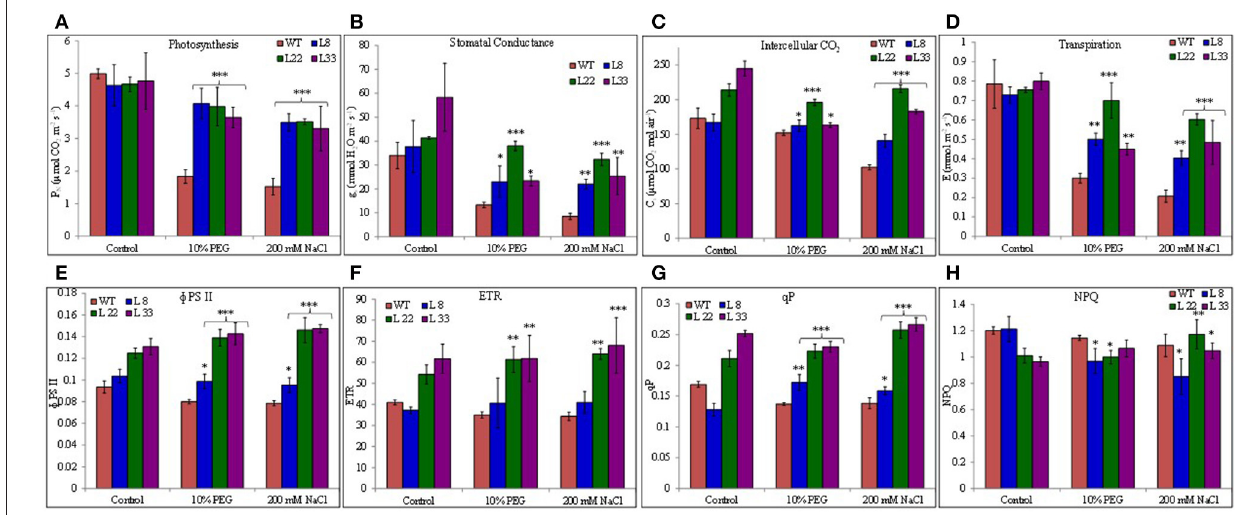
FIGURE 8 | Photosynthetic performances of WT and transgenic tobacco under control and stress (drought and salt) conditions. Comparison of net photosynthesis rate (A) , stomatal conductance (B) , intercellular CO 2 concentration (C) , transpiration rate (D) , PSII operating efficiency (E) , electron transport rate (F) , photochemical quenching (G) , and non-photochemical quenching (H) in WT and transgenic tobacco under control and stress (drought and salt) conditions. The *, **, and *** denote statistical significance in responses of transgenic lines against control at P value ≤ 0.05, 0.01, and 0.001 respectively.